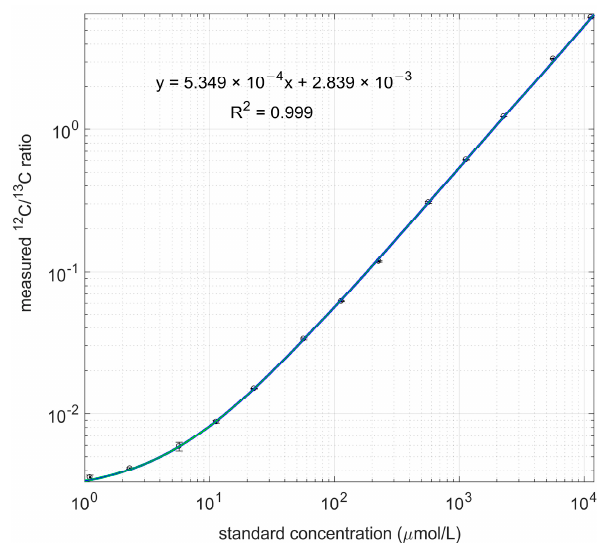
Figure 2. Measured 12 C/ 13 C ratio and linear regression line. Both standard concentration and measured ratio are in log scale.